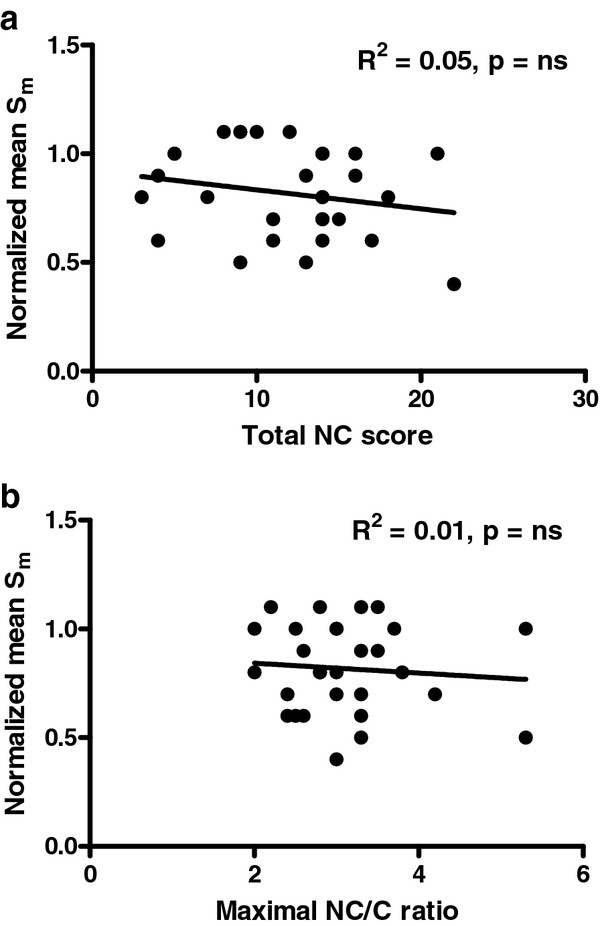
Relation between the mean normalized systolic mitral annular velocities (Sm) and the total noncompaction score (3a), and the maximal noncompaction score (3b).